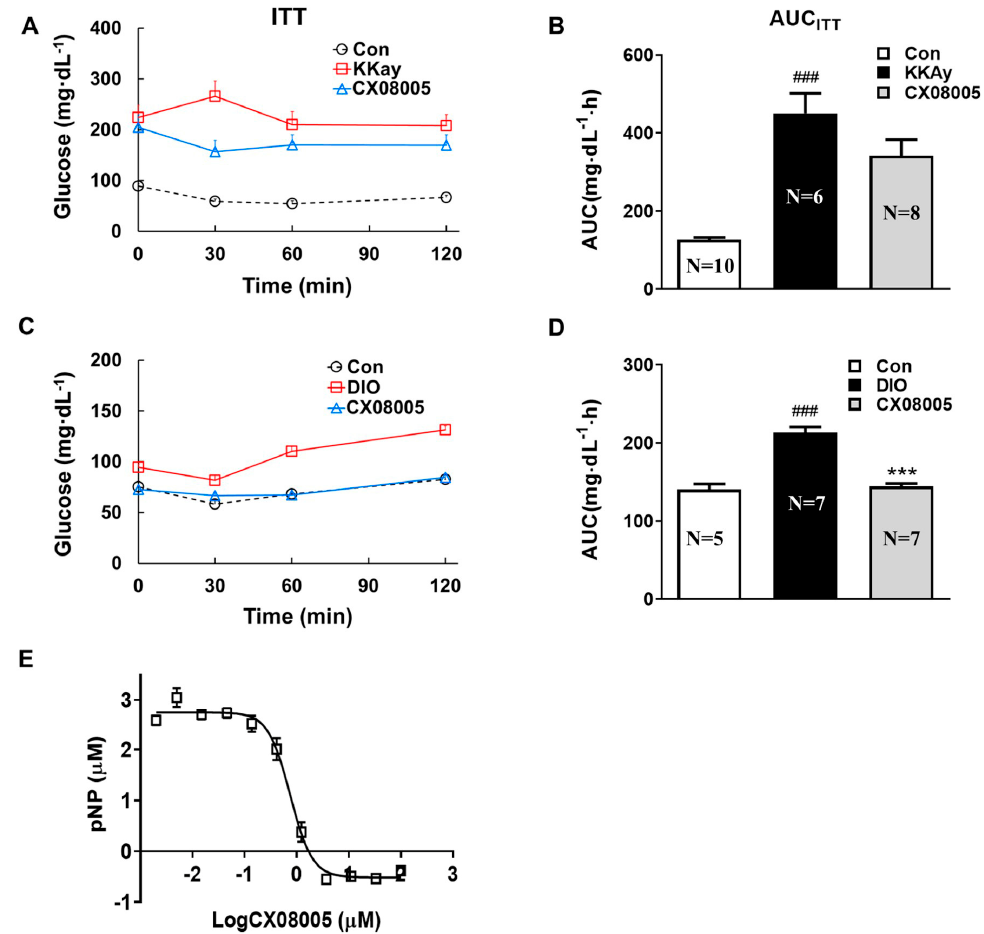
Figure 3. The effects of CX08005 on insulin resistance targeting on PTP1B. After the treatment with CX08005 for 2 weeks, insulin tolerance test was performed in both KKAy and DIO mice (N = 5 − 10). ( A ) Changes of blood glucose levels of ITT in KKAy mice. ( B ) Values of AUC KKAy . ( C ) Changes of blood glucose levels of ITT in DIO mice. ( D ) Values of AUC DIO . ( E ) IC 50 value (N = 3). Data are expressed as mean ± SEM. ### p < 0.001 versus Con; *** p < 0.001 versus KKAy or DIO mice.